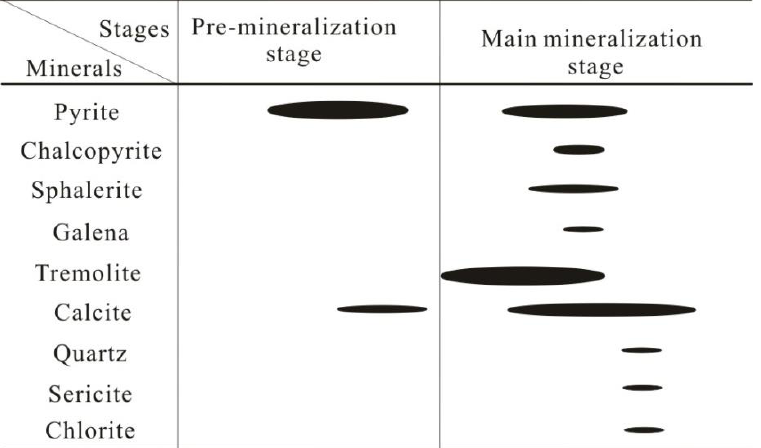
Figure 3. Paragenetic chart showing ore and gangue minerals in the Lijiapuzi gold deposit.